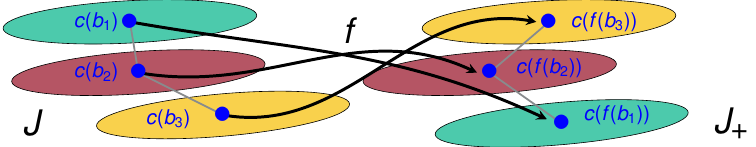
Figure 5. Illustration of an undesirable flip for the mapping f . The cells b 1 and b 3 are neighbors of b 2 , and mapped by f on neighbors z 1 = f ( b 1 ) , z 3 = f ( b 3 ) of z 2 = f ( b 2 ) , as should be expected for bona fide cell registrations. However, for this mapping f , we have z 3 above z 2 above z 1 , whereas, for the original cells, we had b 1 above b 2 above b 3 . Our cost function penalizes flips of this